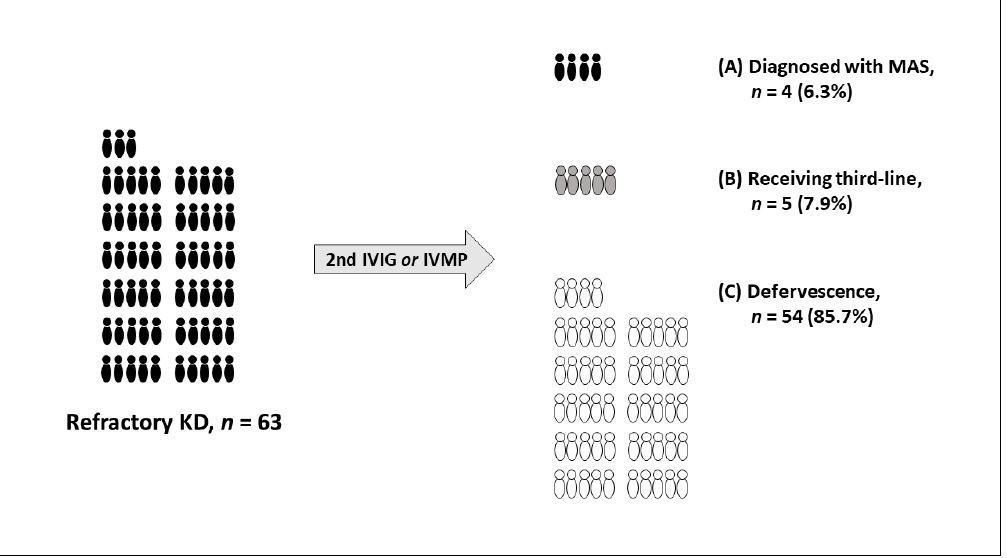
Figure 1. Clinical course of 63 patients with refractory KD after second IVIG or IVMP treatment. (A) Four patients (6.3%) diagnosed with MAS, (B) five patients (7.9%) receiving third-line treatment, and (C) fifty-four patients (85.7%) with no further febrile episodes. KD, Kawasaki disease; MAS, macrophage activation syndrome; IVIG, intravenous immunoglobulin; IVMP, intravenous methylprednisolone. Third-line treatment refers to cyclosporine, steroids, HLH-2004 therapeutic regimen [8], intravenous methylprednisolone, intravenous immunoglobulin, or infliximab.